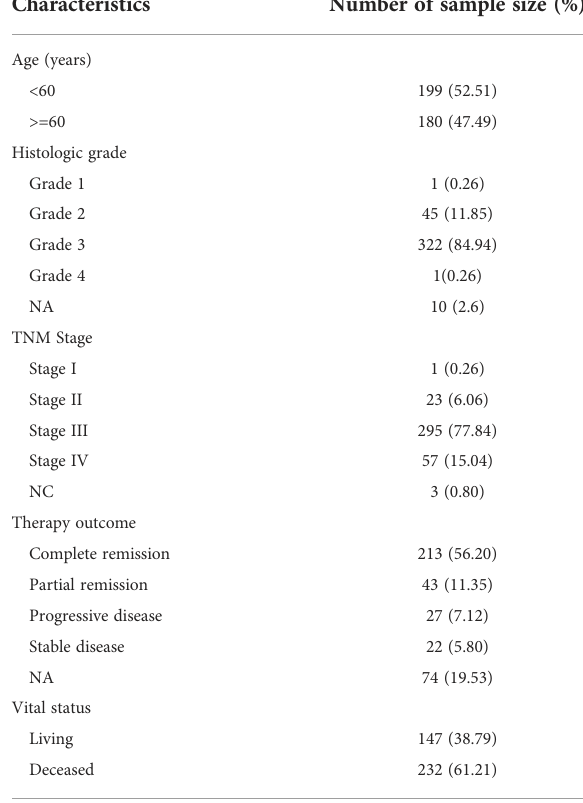
TABLE 3 Clinical characteristics of the 379 OC